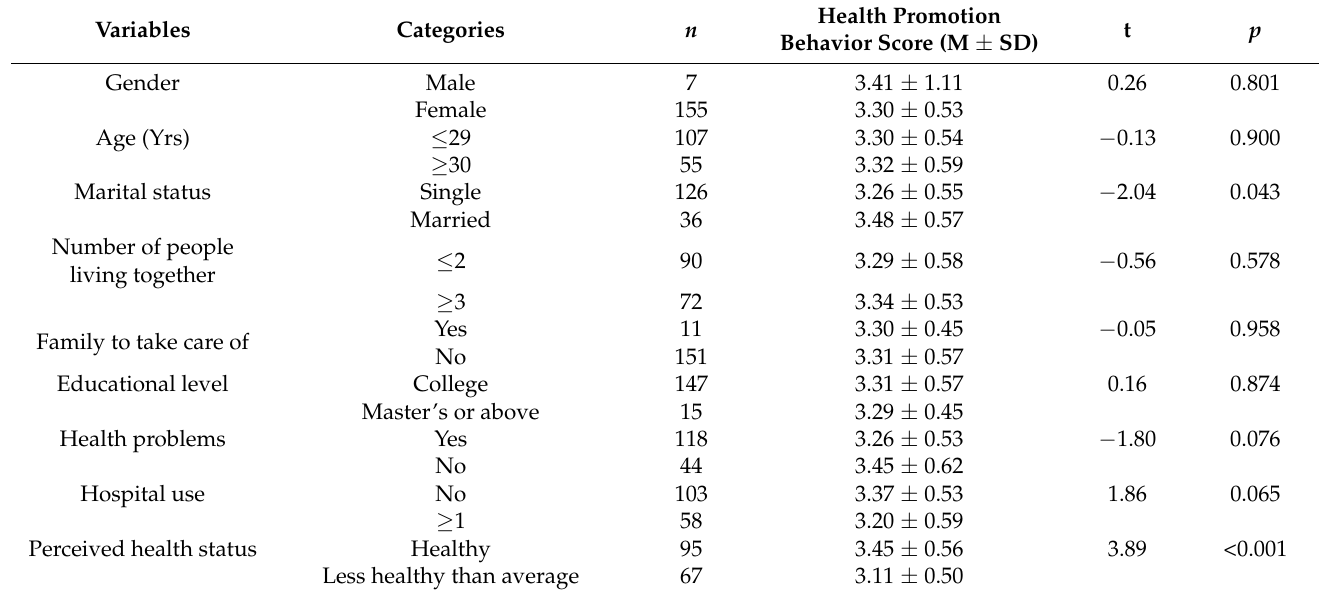
Table 1. Participant Characteristics and Their Relationship to Health Promotion Behavior (N =